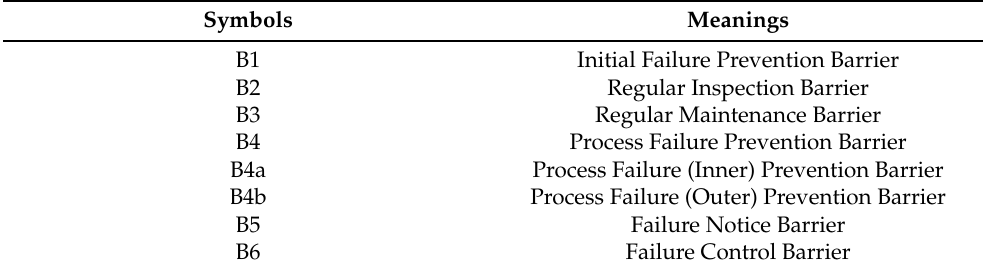
Table 1. Definitions of barriers.